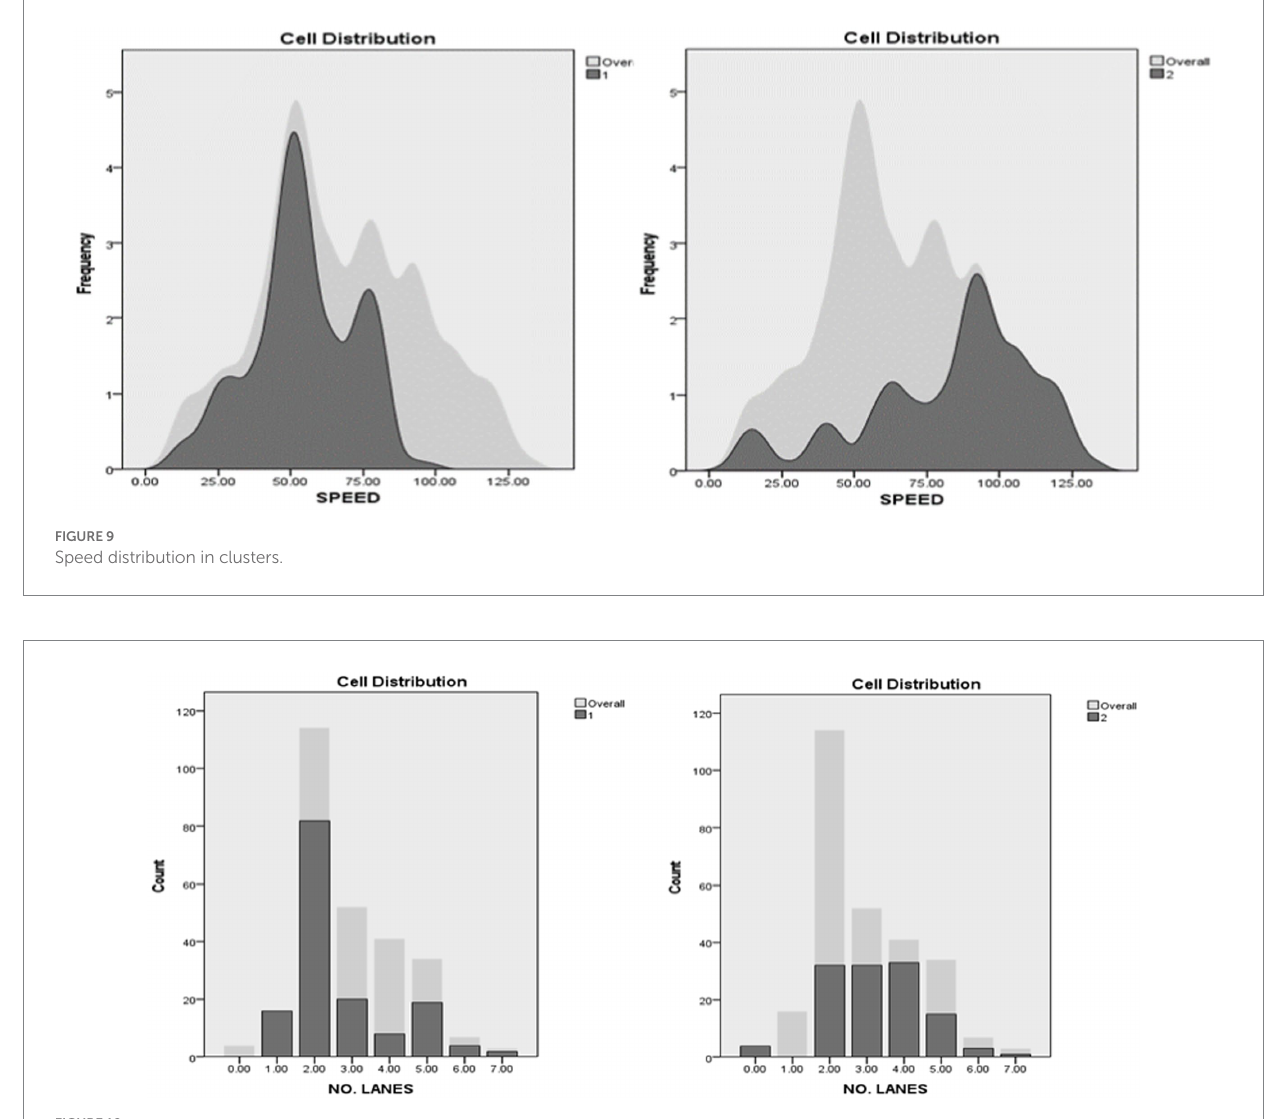
FIGURE 10 Number of lanes distribution in